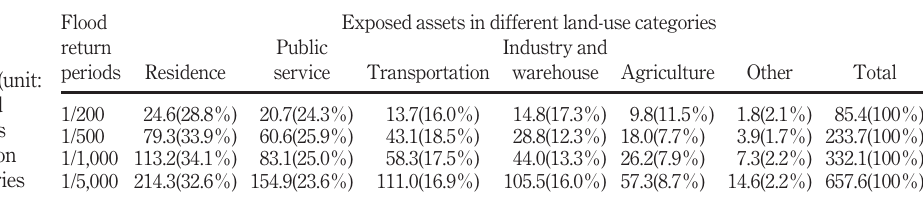
Exposed assets in different land-use